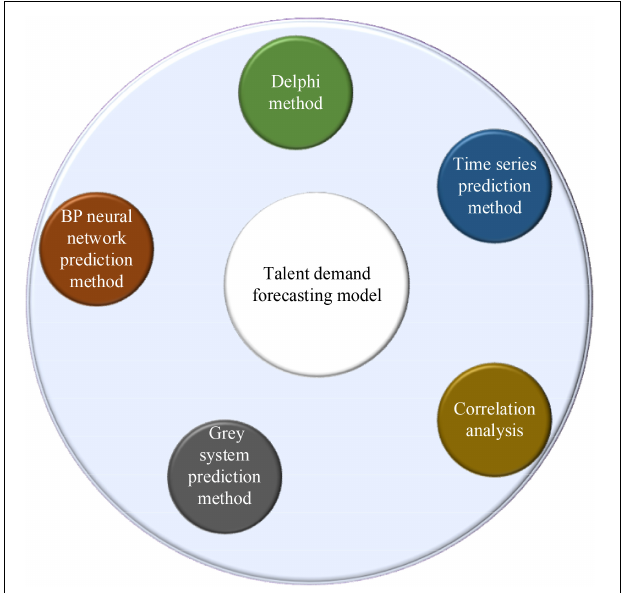
FIGURE 2 | Talent demand forecasting